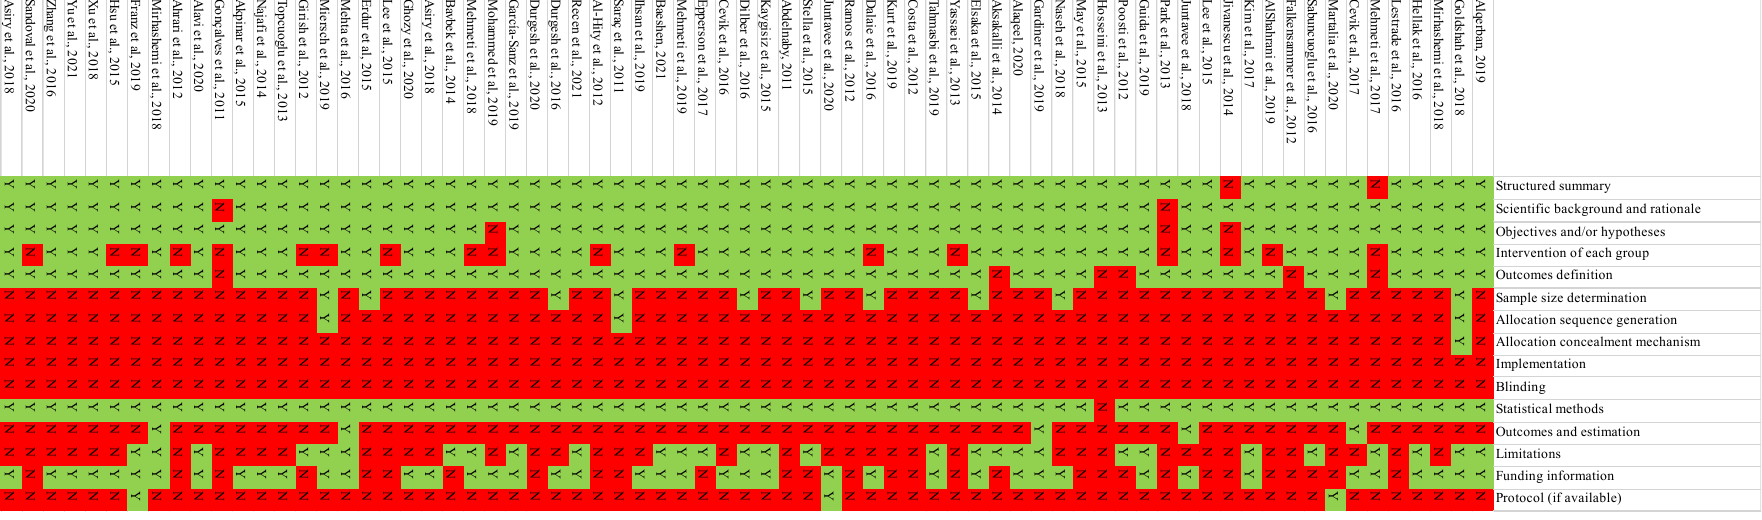
Figure 2. Y—yes; N—no. Risk of bias of the included studies.